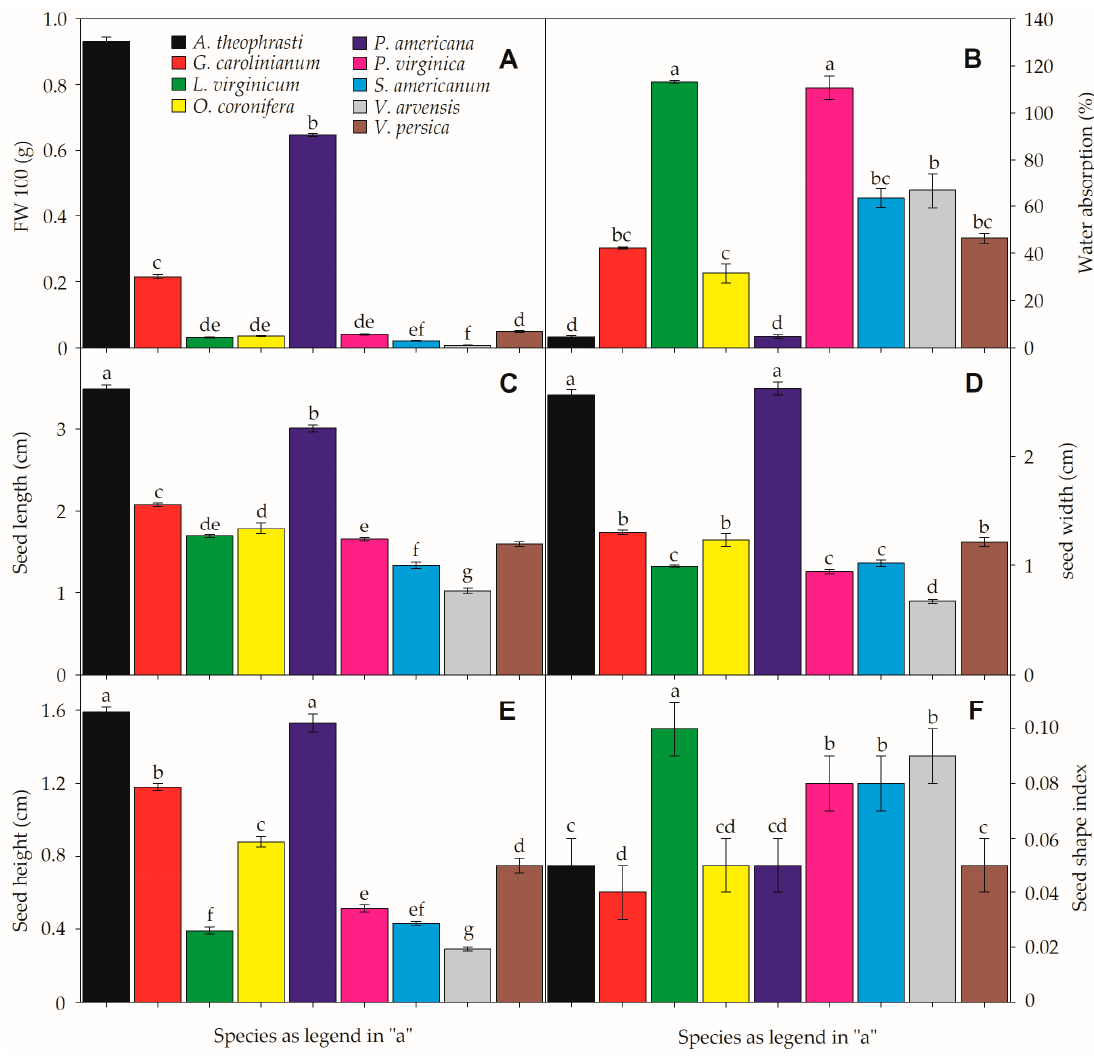
Figure 1. Seed functional traits of the nine invasive species. Fresh weight ( A ), water absorption ( B ), seed length ( C ) seed width ( D ), seed heighjt ( E ), and seed shape index ( F ). Small-case letters denote significant differences between species in each feature. All data represent the means (± SE). α = 0.01. For more details on the study species, please check Table 1 and Supplementary Table